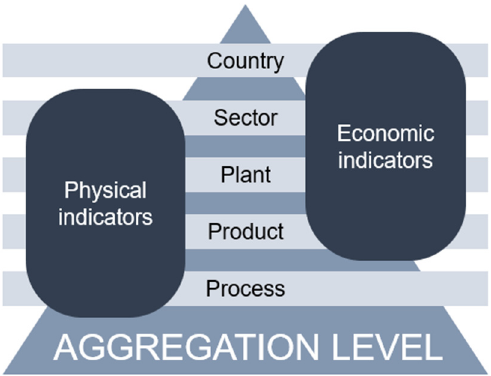
Figure 4. Physical and economic indicators according to aggregation level. Adapted from [38].